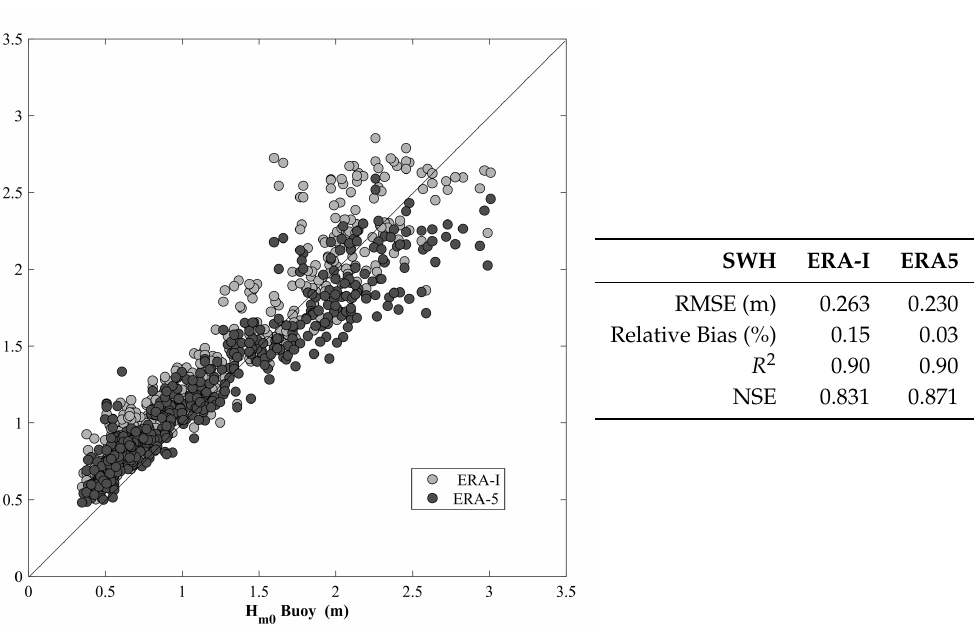
Figure 9. Comparison of the synchronous wave heights extracted from ERA wave models against the back-propagated observed wave heights at the nearest ERA5 grid